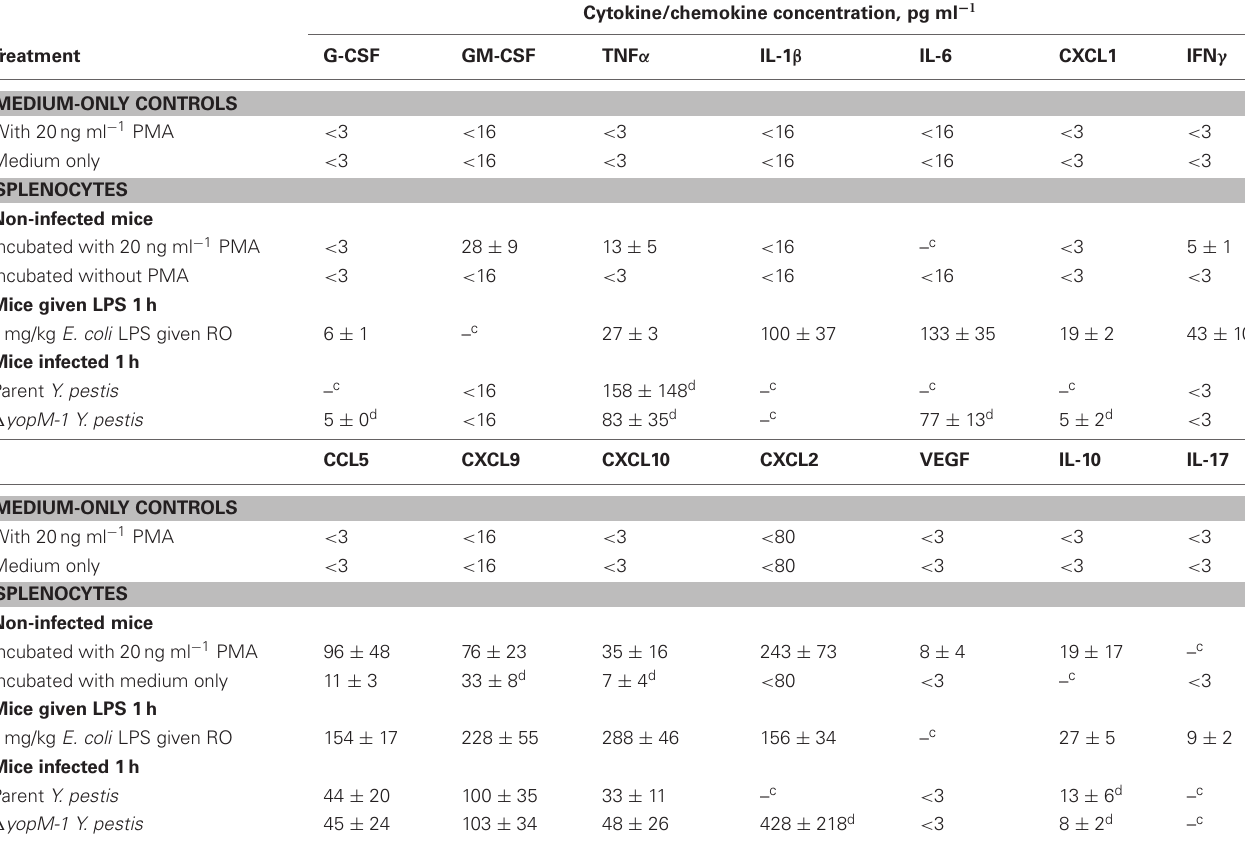
Table 3 | Control tests for multiplex analysis of chemokines and cytokines a,b